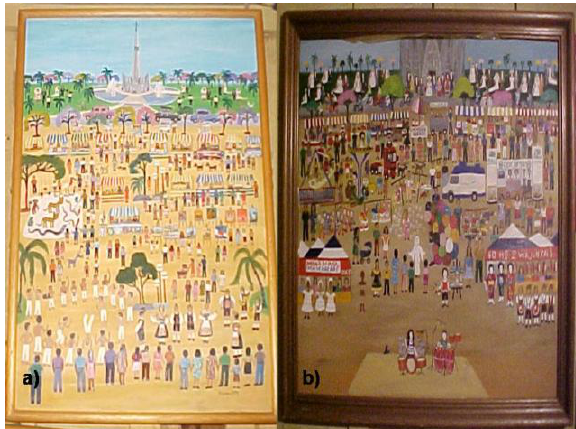
Figura 2. a) Festa das Nações (1999); b) Festa das Nações (2004). Fotografias: Fabiane Castilho Teixeira; Telas: Lilia